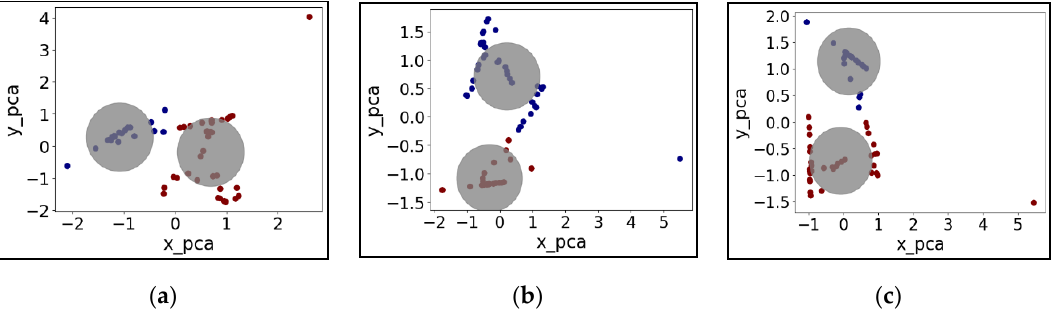
Figure 2. Principal component scores for the two components (x_pca means the first component score; y_pca means the second component score) by K-mean under varying rainfall scenarios: ( a ) 3 h’ duration rainfall, ( b ) 12 h’ duration rainfall, ( c ) 48 h’ duration rainfall. The principal component scores are used to examine if these two clusters are reasonably distinguished from each other clustering (gray circles the blue and red dots assigned to the closest cluster).